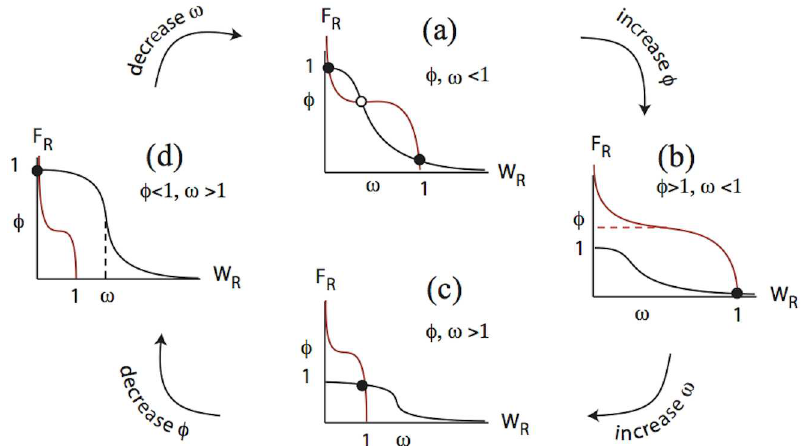
Fig 4. Analysis of mutual inhibition dynamics leads to model insights. The scaled mutual inhibitionEq (7) can have one of four possiblebehavioursrepresented by nullclines in the W R F R phase plane.( F R nullcline in black, W R nullclinein red.) (a) Bistability, in which either a highWnt receptor ( W R ) or high FGF ( F R ) receptor expressingstate can result, dependingon initial conditions. (b) A Wnt-receptor expressingstate always result, (c) a coexistence-state, with both Wnt and FGF receptors expressed,and (d) an FGF only receptor expressionstate exists. When the Hill coefficients n , m are large, the steady states (appropriatelyscaled) occur approximately at a subset of the points {(1, 0), (1, 1), (0, 1)} and transitions betweenthe four qualitative outcomesdisplayedin this figure can be summarized by simple inequalitiesin terms of aggregatequantities ϕ and ω , see Eq